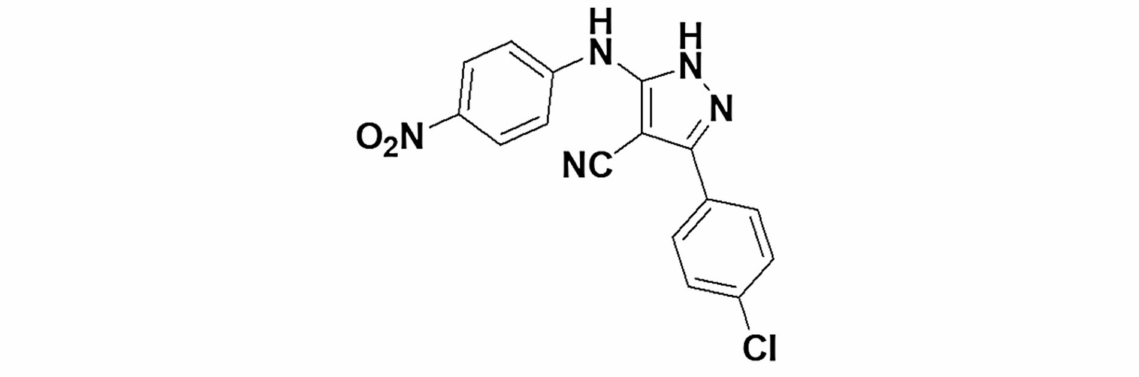
Figure 1. Chemical structure and chemical name of